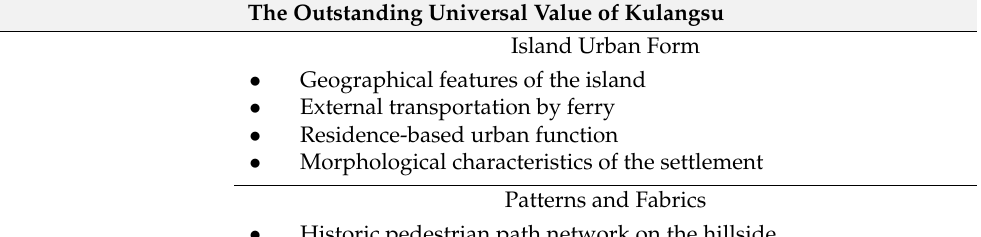
Table 4. The Outstanding Universal Value of Kulangsu heritage site (made by